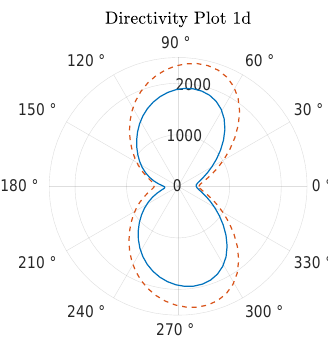
Figure 11. Directivity plot of p rms [Pa] determined by the linear solution of the FW-H equation at r = 1 d : solid line, rigid cylinder; dashed line, elastic